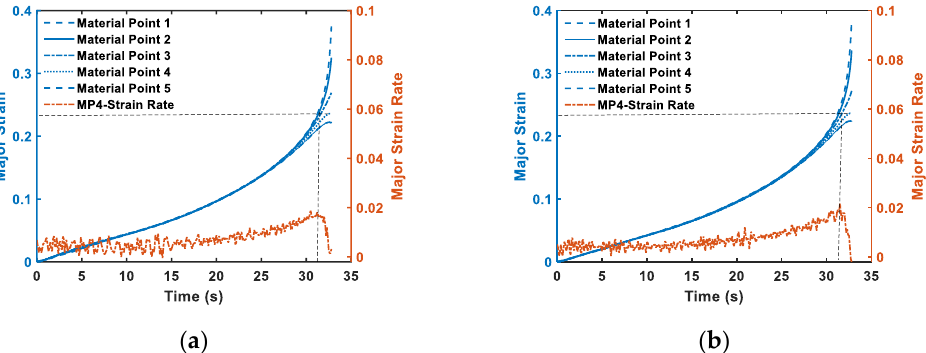
Figure 12. Major strain and strain rate evolution for two independent tests on a 25 mm wide speci- men: ( a ) the first test; ( b ) the second test.